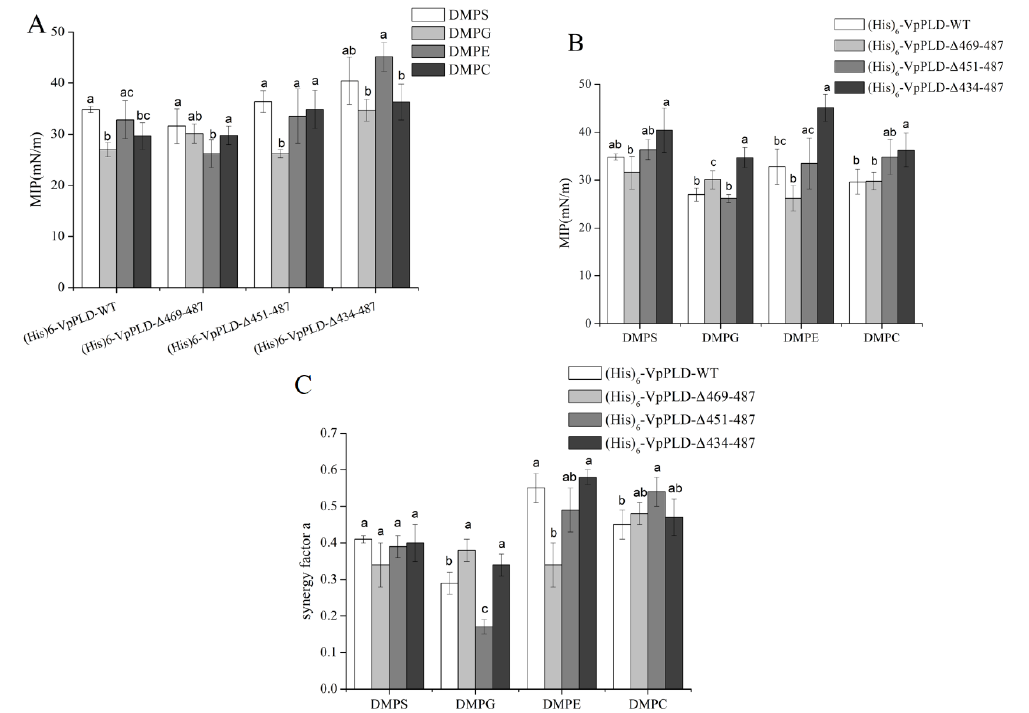
Figure 6. MIP ( A , B ) and Synergy factor a ( C ) of (His) 6 -VpPLD-WT and its C-terminal truncated mutants ((His) 6 -VpPLD-Δ469-487, (His) 6 -VpPLD-Δ451-487, and (His) 6 -VpPLD-Δ434-487) in the presence of different phospholipid monolayers. The statistical analysis of the data allowed to determine the values which were significantly different (labeled with different letters) ( p = 0.05). Basically, no significant difference could be found between (His) 6 -VpPLD-WT, (His) 6 -VpPLD- Δ469-487, and (His) 6 -VpPLD-Δ451-487 for DMPS, DMPE, and DMPC. For example, for the DMPS, the MIP value for these three proteins was 34.8 ± 0.6 mN m −1 , 31.2 ± 3.4 mN m −1 , and 36.4 ± 2.1 mN m −1 , respectively ( p > 0.05). For DMPE, the MIP value for these three proteins was 32.8 ± 3.7 mN m −1 ,